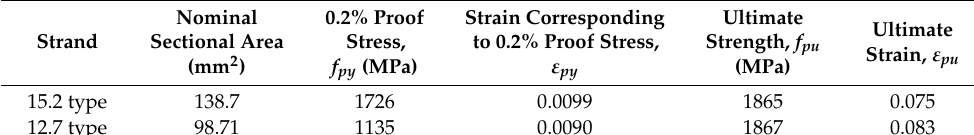
Figure 10. ( a ) Test setup, ( b ) failure of non-corroded strand, and ( c ) failure of corroded strand.